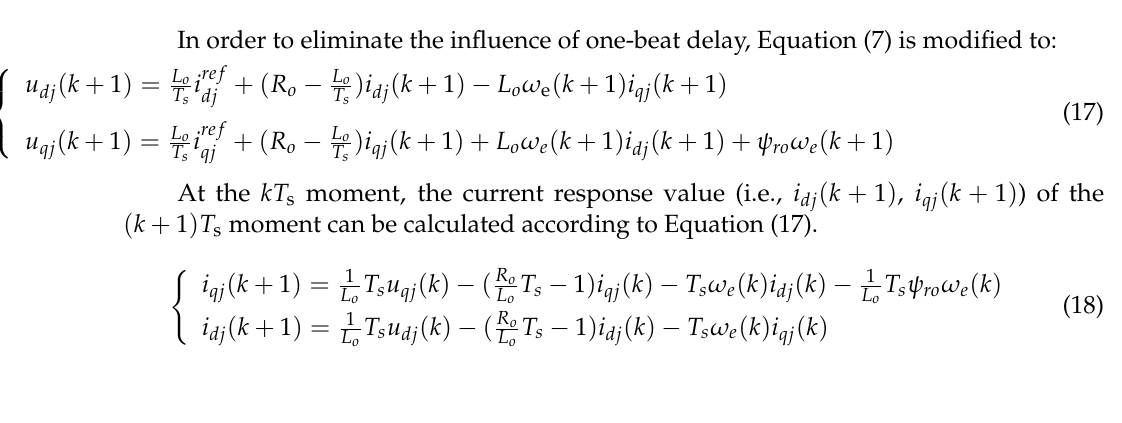
Figure 5. Principle diagram of one-beat delay compensation.